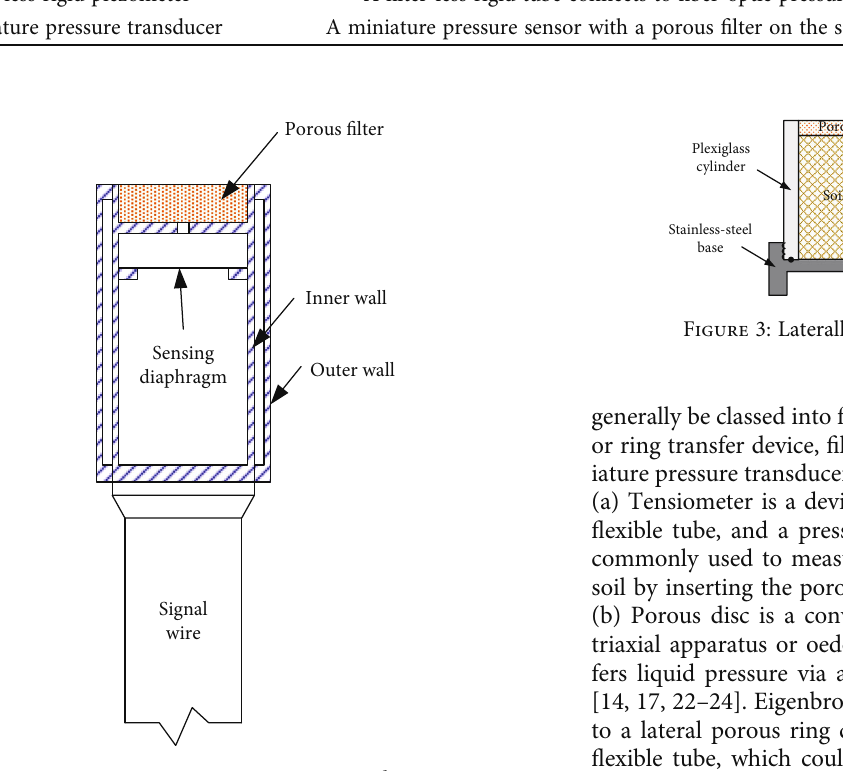
Figure 2: Miniature pressure transducer.